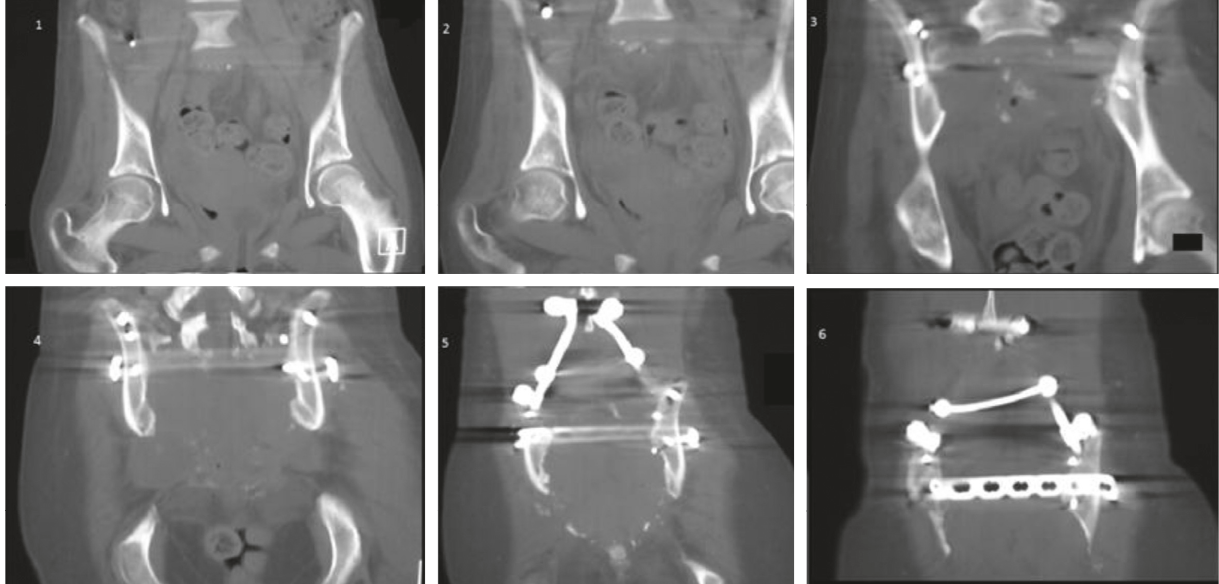
Figure 6: Postoperative CT (coronal slices) showing a complete removal of the